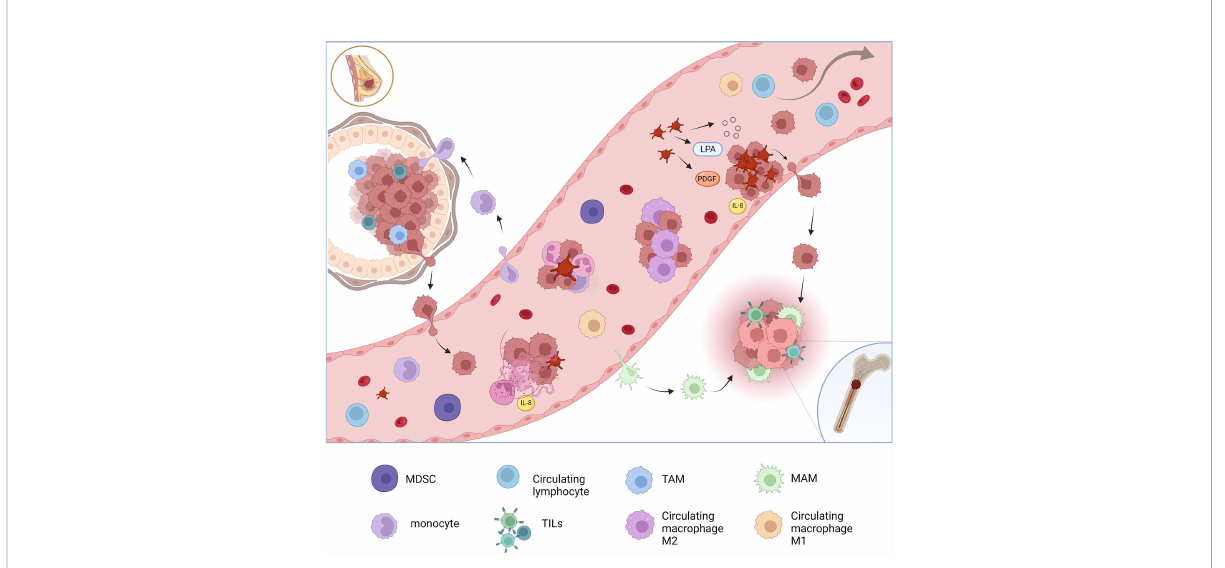
FIGURE 1 Circulating in fl ammatory cells in blood fl ow in breast cancer. In fl ammatory cells are involved in many ways in promoting cancer cells invasiveness. Evasion of tumor cells from the primary site into circulation is partially permitted by tumor associated macrophages and other immune cell responsible for an immunouppressive microenvironment. Immune cells are also attracted by tumor factors from the blood fl ows. Circulating tumor cells (CTCs) in blood fl ow are accompanied in cluster with macrophages and monocytes. Neutrophils release neutrophils extracellular traps (NETs) that determines aggregation of CTCs and other immune cells guaranteeing their survival and a favorable microenvironment in circulation. Platelets, activated by tumor promoting factors, trigger hemostasis mechanisms that catch CTCs cells favoring the adhesion to vessel walls. Lysophosphatidic acid (LPA) dependent mechanism, platelet derived growth factors (PDGFs), interleukin-8 (IL-8) and platelet-derived extracellular vesicles (PEVs) contribute to the formation of platelet clots that include and protect CTCs. CTCs that are not included in aggregates are unlikely to survive in the bloodstream. Immune cells are also important in the formation of the metastatic-niche. Macrophages associated to metastasis (MAMs) derive from the bloodstream and are recruited in the process of metastasis. Adapted from “ Breast Cancer to Brain Metastasis ” , by BioRender.com (2022). Retrieved from